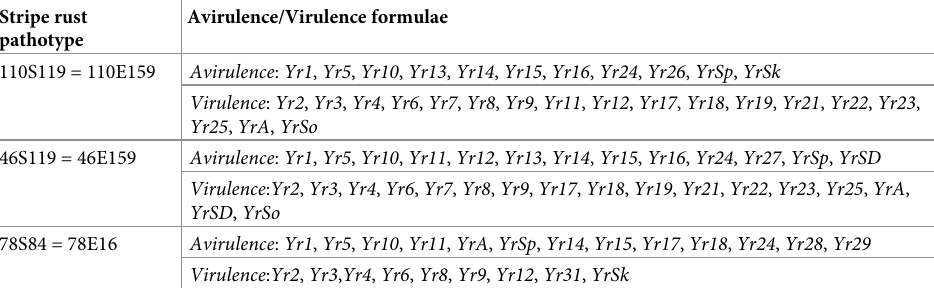
Table 1. Avirulence/virulence profile of Puccinia striiformis fsp tritici pathotypes Pst46S119, Pst110S119 and Pst78S84. Stripe rust